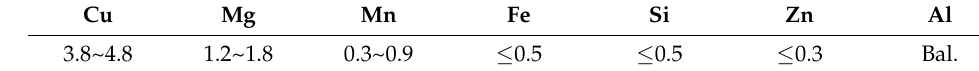
Table 2. Chemical composition of 6061 aluminum alloy (mass fraction/%) .